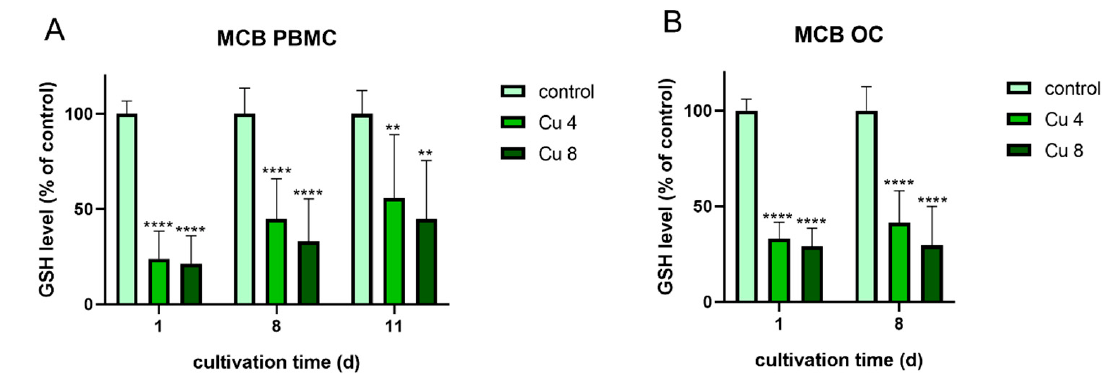
Figure 10. Glutathione levels of PBMC during osteoclastic differentiation ( A ) and of mature osteoclasts ( B ) in the presence of 4 and 8 µ M Cu 2+ compared to a copper-free control. Data of three different PBMC donors (each n = 3; n = 9 in total per group and time point) were included into the calculations. Statistically significant differences were calculated by 2-way ANOVA followed by Tukey’s multiple comparisons test * p < 0.05, ** p < 0.01, *** p < 0.001, **** p <